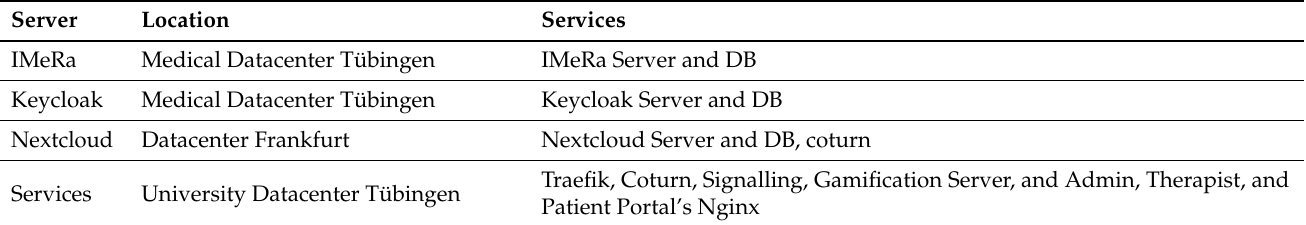
Table 2. Overview of servers, their location, and their provided